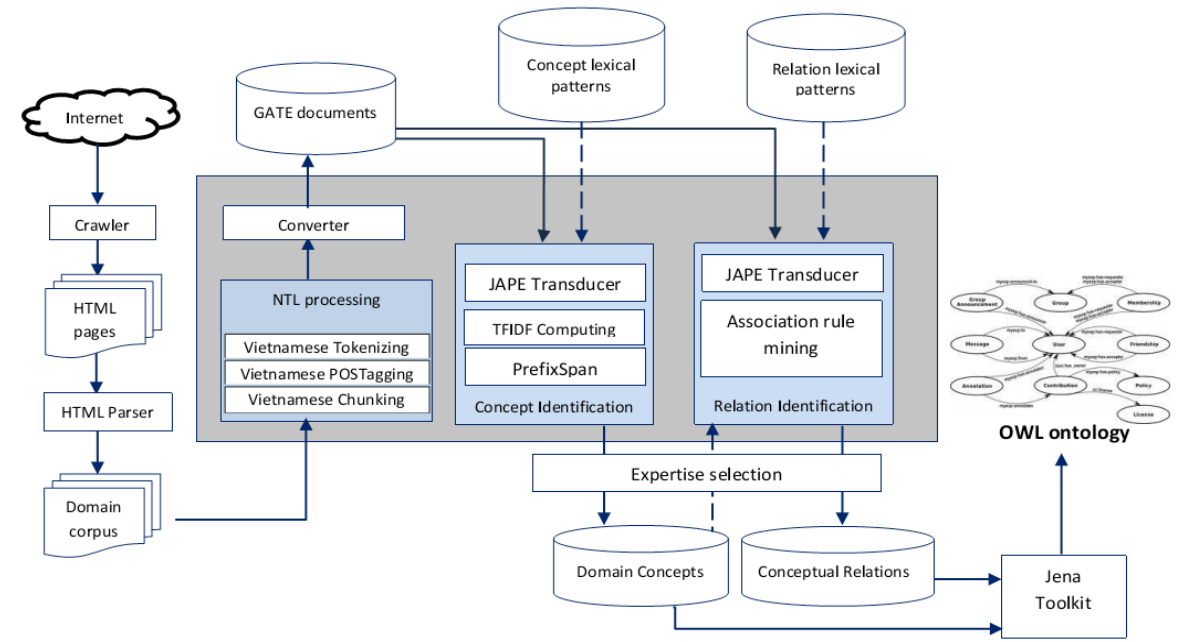
Figure 3. Overall construction